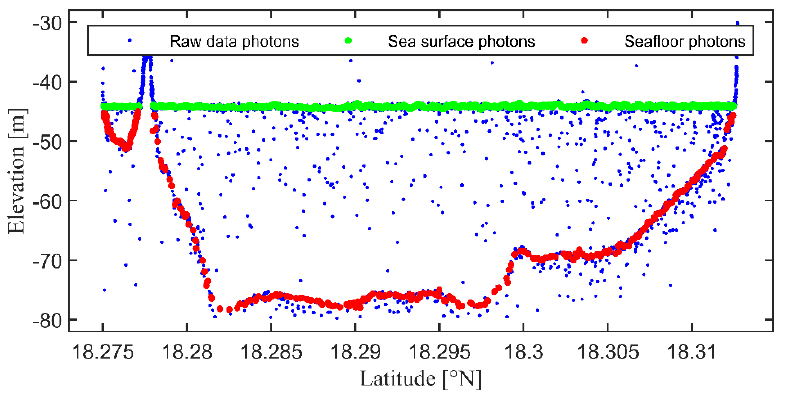
Figure 9. The raw photon point cloud of ATL03 for 20190221GT1L in the St. Thomas area.